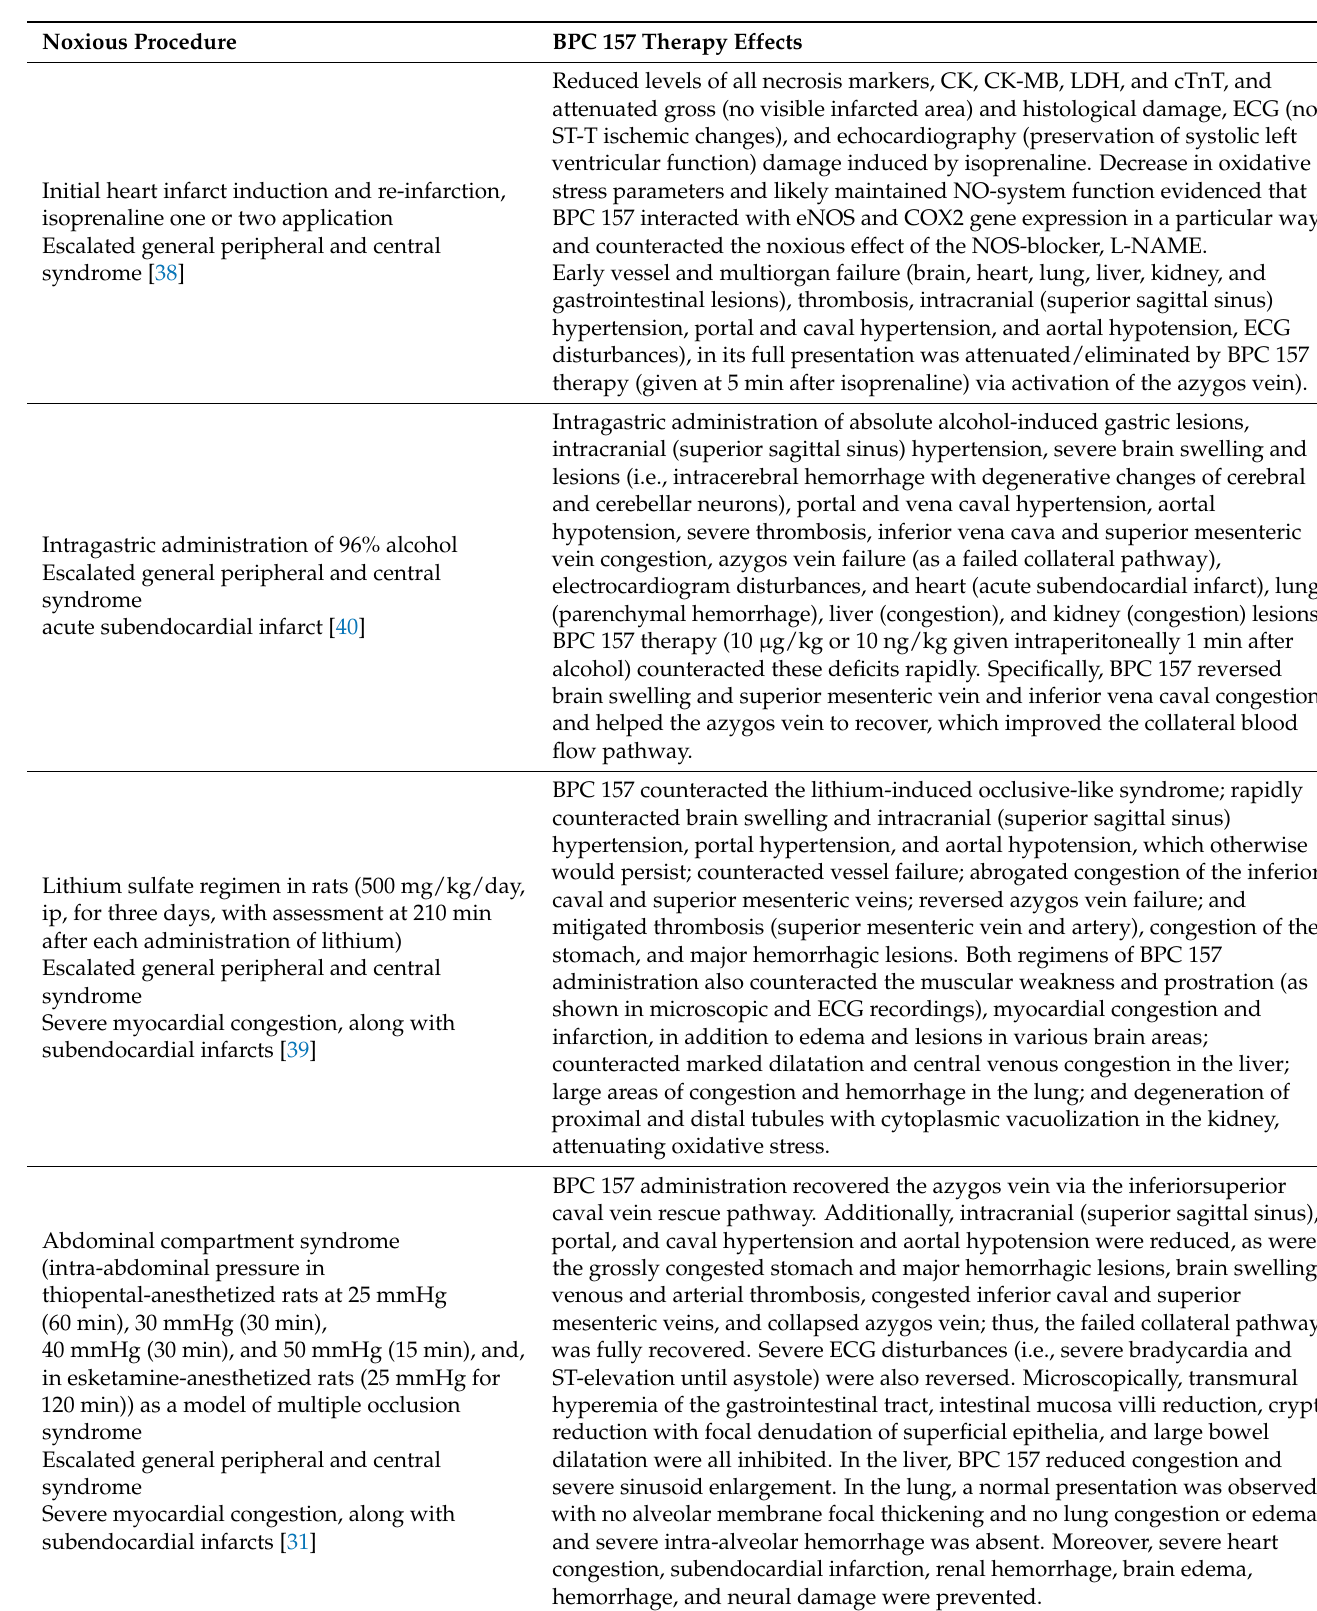
Table 1. Summarized presentation of the BPC 157 therapy effect on myocardial infarction and